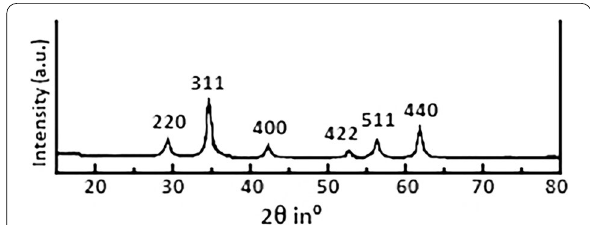
Fig. 5 X‑ray diffraction chart presenting the magnetite characteristic